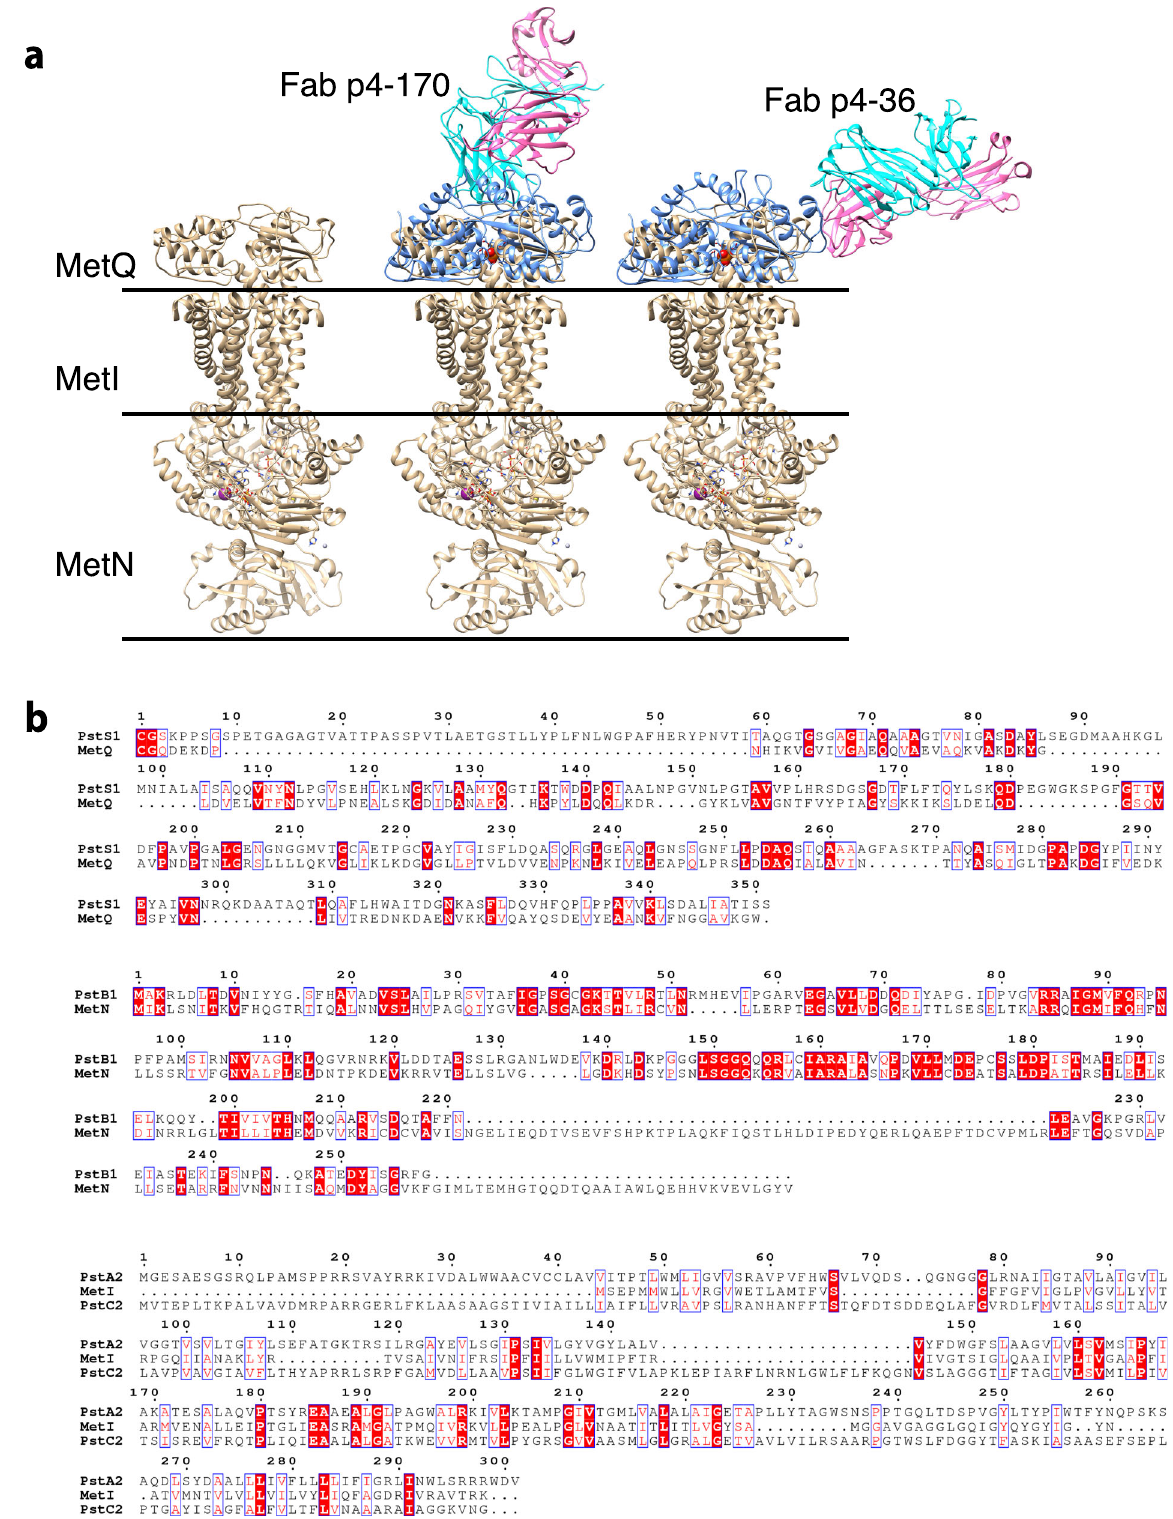
Fig. 5 Structure modeling of the binding of PstS1 to the PstA – B – C phosphate transporter complex. a Structural superimposition of the Fab – PstS1 complexes with MetQ of the MetNIQ ABC transporter complex (in gold) (PDB code: 6CVL) suggested a possible binding mode of PstS1 to the PstA – B – C phosphate transporter complex. The bound antibodies show no blockage to the assembly of the PstA – B – C – S complex. b Sequence alignments showing that the MetNIQ complex components share signi fi cant sequence similarities to these of the PstA – B – C phosphate transporter complex of